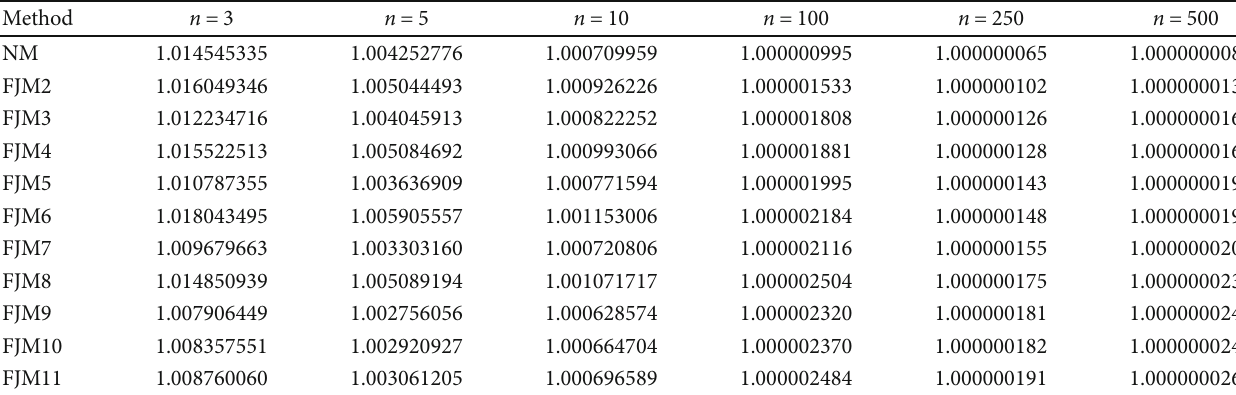
Table 34: Values of FLEI for the methods in the third category to solve Test Problem 1, and n = 3, 5, 10,100,250,500 . Method